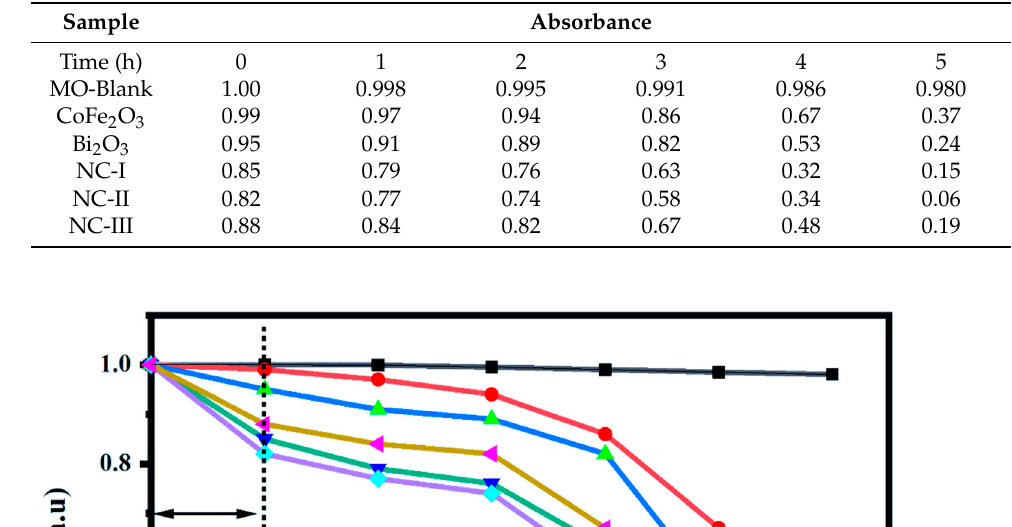
Table 3. Absorbance values of dye solutions charged by various as-prepared photocatalysts during photodegradation experiment in comparison to blank.